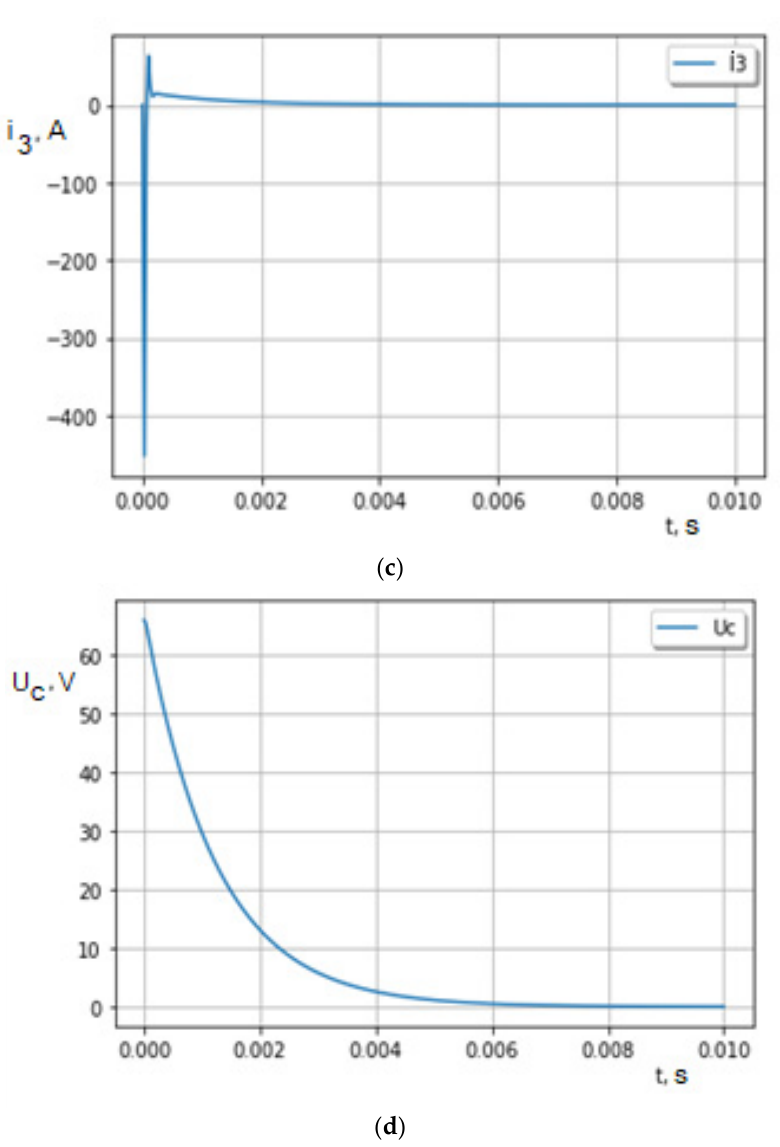
Figure 3. Diagrams during discharge of capacitive storage, the maximum values are: ( a ) i 1 = 850A, ( b ) i 2 = 380A, ( c ) i 3 = 530A—of electric current intensity; ( d )—electric voltage; [own elaboration], graphs that visually show the dependence of the corresponding functions on the arguments.